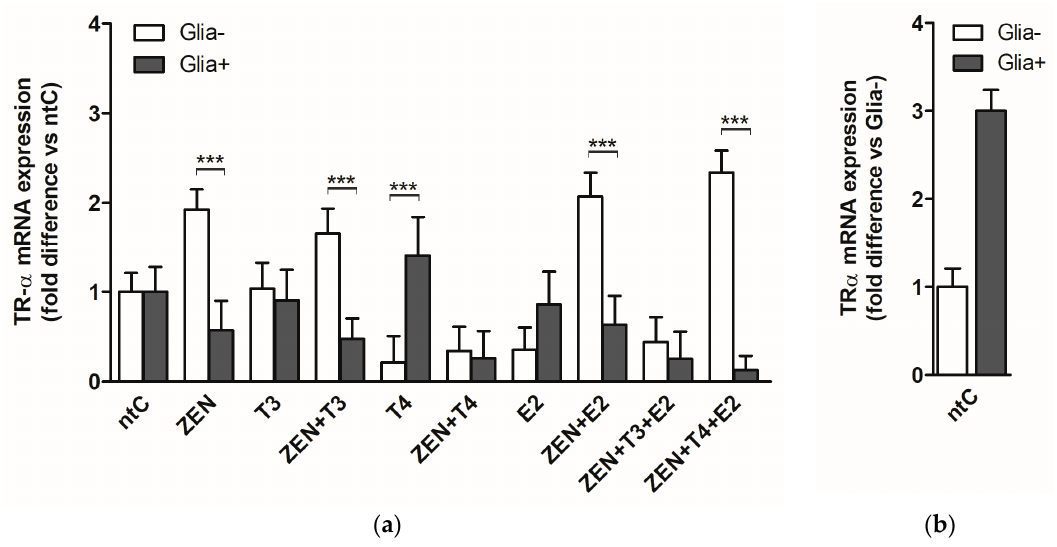
Figure 1. TR α mRNA expression in cerebellar granule cells in the absence, Glia − , or presence of glial cells, Glia+; treated with zearalenone (ZEN), and/or triiodo-thyronine (T3), thyroxine (T4) and 17 β -estradiol (E2) for 6 h. ( a ) Relative expression level of the TR α gene was analyzed by qRT-PCR and normalized to the average of the control gene β -actin. Shown P-values were calculated as follows: Glia+ compared to Glia − (***) p < 0.001 in each treatment group. ( b ) Relative expression of TR α mRNA in non-treated controls normalized to β -actin ( p -value not shown). The data shown here are the mean ± standard deviation (SD) of at least three independent experiments ( n = 6 per treatment).